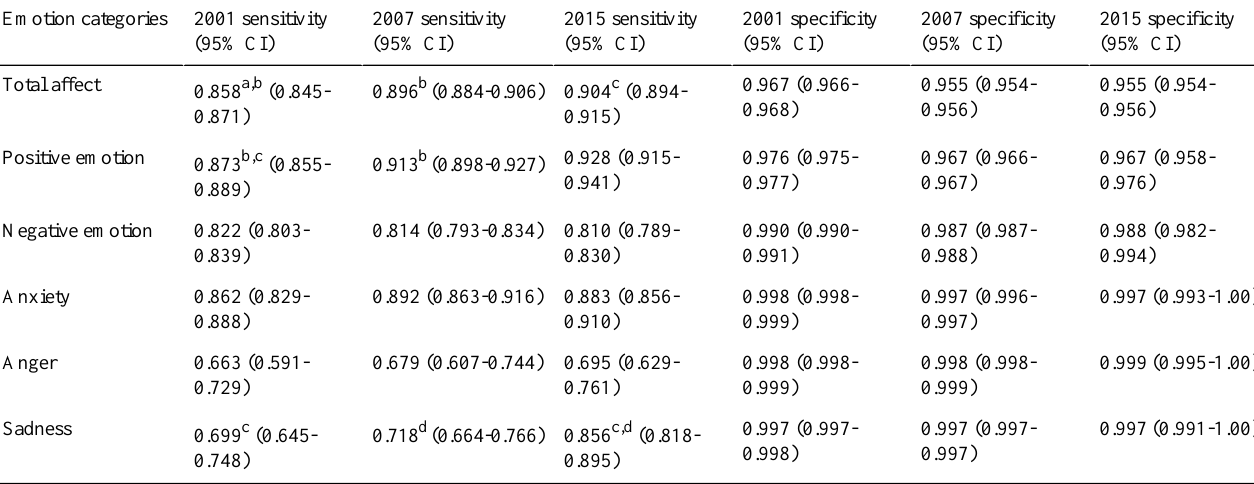
Table 4. Linguistic Inquiry and Word Count 2001, 2007, and 2015 sensitivity and specificity with 95% CI (N=63) a